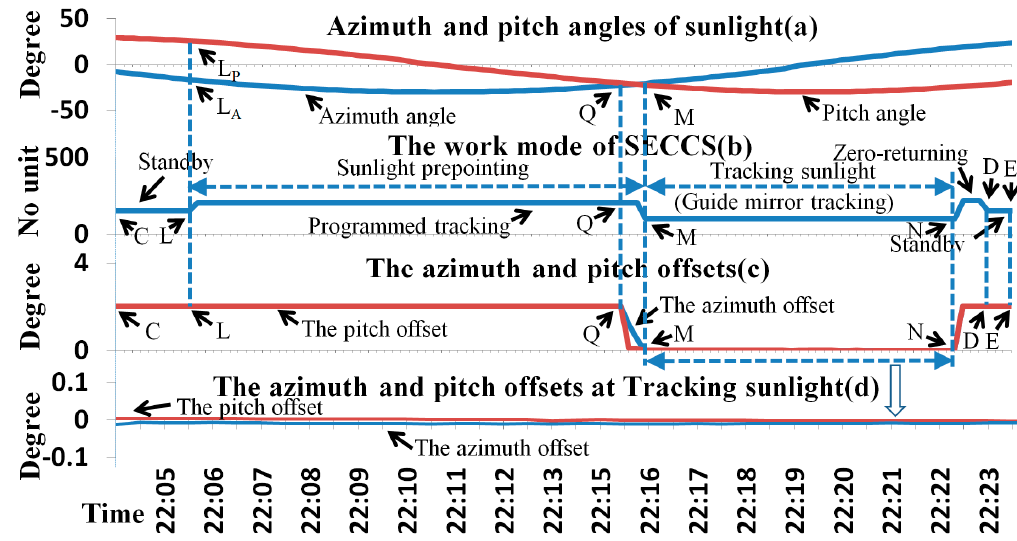
Figure 8. The work mode and angle using the primary method. The rotation range of the turntable azimuth direction was changed from − 30°~24° to − 21°~24° according to the injection parameters, and the rotation range of the pitch direction was − 34.5°~0°. When the sunlight was outside the field of view of the guide mirror, the offset returned by the mirror was a fi xed value of 2°. All data readings transmi tt ed to the ground cycle was 32 s.